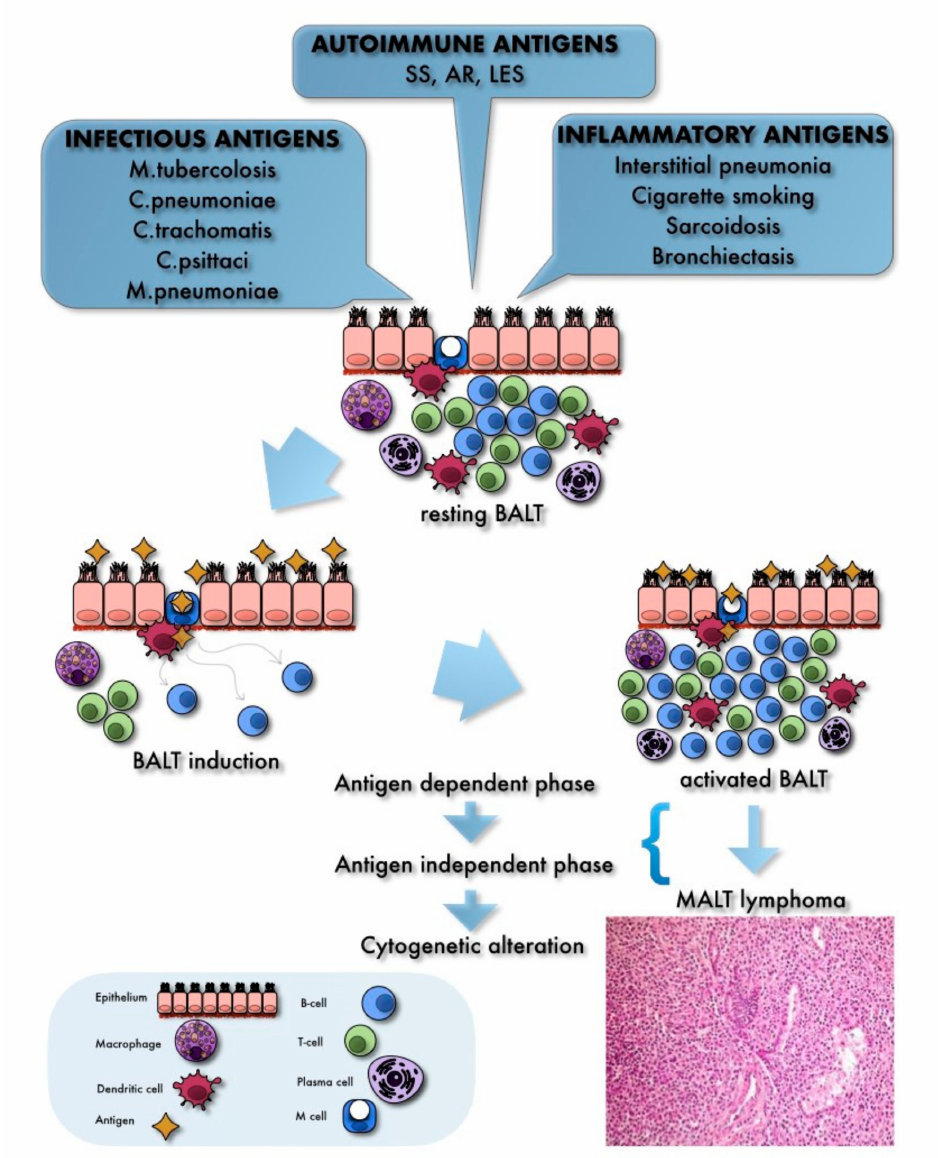
Figure 1. The stepwise progression from BALT to MALT